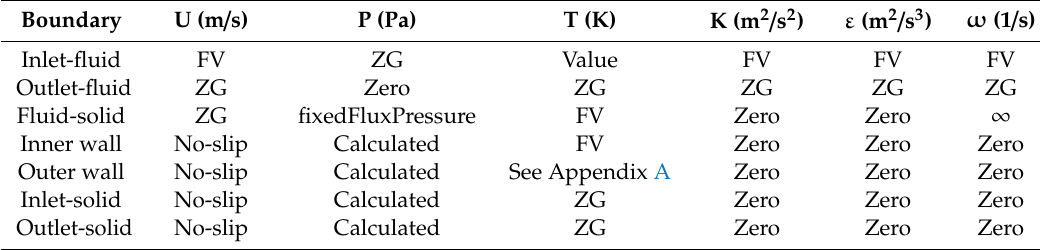
Table 6. Boundary condition of fluid and solid variables applied in the current study; FV: means fixed value and ZG: means zero gradients.